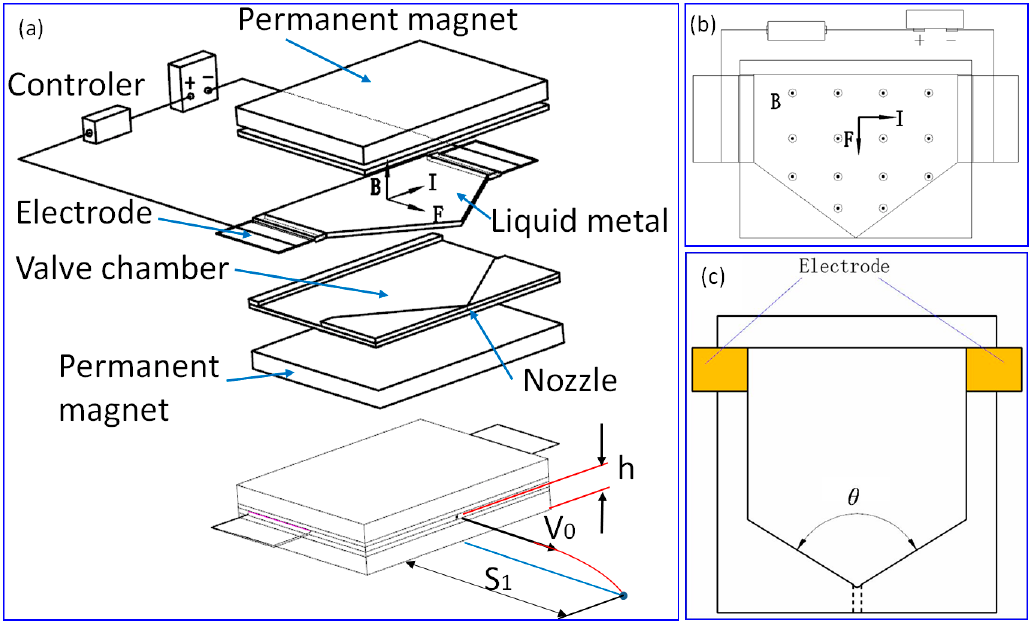
Figure 2. ( a ) 3D view and parameters of the experiment device. ( b ) 2D view of the experiment device. ( c ) Schematics of the jetting valve.